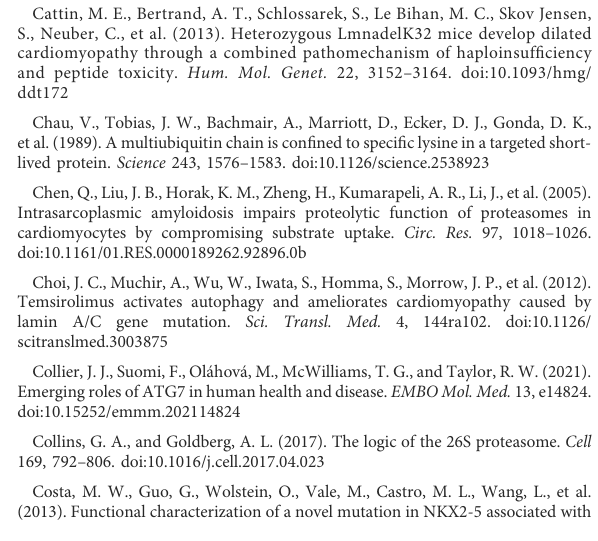
SUPPLEMENTARY FIGURE S1 Lamin A and C staining after NH 4 Cl treatment. (A) Pearson ’ s correlation coef fi cients of p62 and LC3-I/II stainings as determined from untreated and NH 4 Cl-treated control and patient cells. The data was retrieved from 10 randomly selected confocal images including 60-100 individual cells per sample. Note an increased correlation upon NH 4 Cl treatment. (B) Pearson ’ s correlation coef fi cients of p62 and lamin A/C stainings as determined from untreated and NH 4 Cl-treated control and patient cells. (C) Control and patient cells stained with antibodies against p62 and lamins A and C show slightly increased lamin A and C intensities after treatment with 20 mM NH 4 Cl for 24 h. Scale bar 10 µm. The whiskers show mean values ± s.d * p < 0.05. SUPPLEMENTARY FIGURE S2 Cytoplasmic changes after proteasome inhibition with MG132. (A) Acridine orange staining from untreated and MG132-treated control and patient cellsshowingacidicvesicularorganelles(AVO)inredandcellnucleusand membranes in green. (B) Treatment of control and patient cells with 1 µM MG132for24hleadstoaccumulationofcytoplasmicK48ubiquitinwhich is surrounded by perinuclear vimentin cage (shown with arrows). Scale bar 10